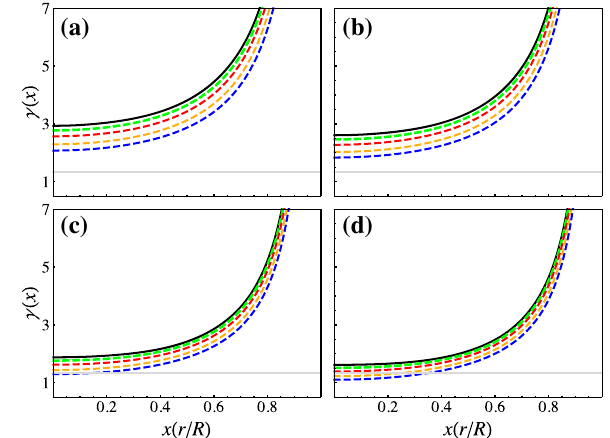
Fig. 7 Radial sound velocity, v 2 r ,for a u = 0 . 13, b u = 0 . 15478, c u = 0 . 2035, d u = 0 . 229365. α = 0 (black solid line), α = 0 . 04, (green dashed line), α = 0 . 1 (red dashed line), α = 0 . 2 (yellow dashed line), α = 0 . 3 (blue dashed line)